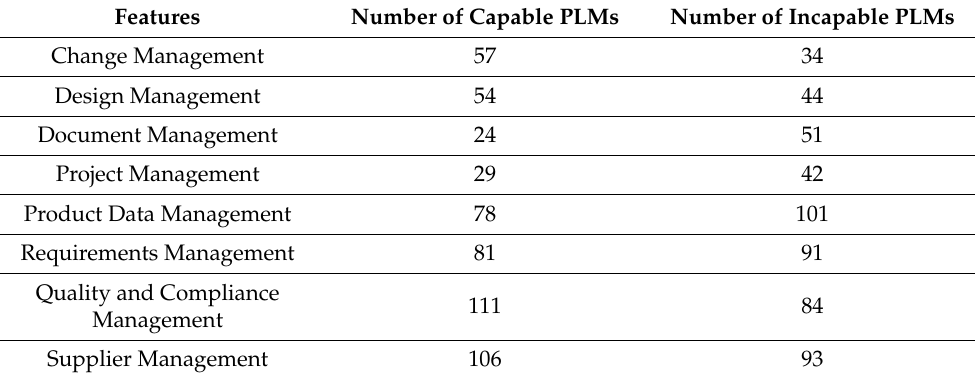
Table 1. Number of PLMs targeting specific